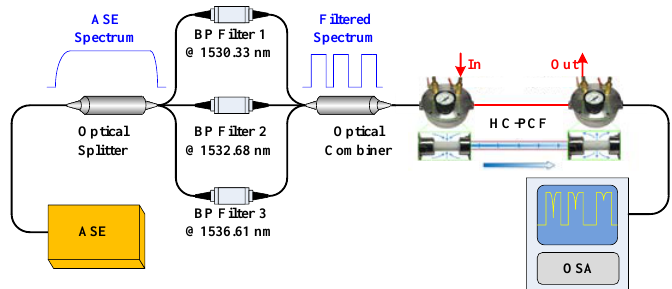
Figure 8. Passive single-pass sensing system. HC–PCF, hollow-core photonic crystal fiber; OSA, optical spectrum analyzer.